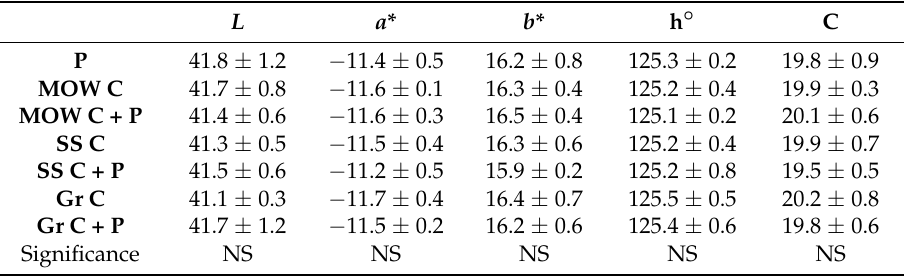
Table 3. Color parameters [ L (lightness), a* (redness), b* (yellowness), h ◦ (Hue angle) and C (saturation)] of sea fennel grown on seven substrates composed of peat and three different composts containing posidonia residues. A peat-based commercial substrate was used as control. The compost materials were tested alone or in mixture with peat (at a rate of 50% on a volume